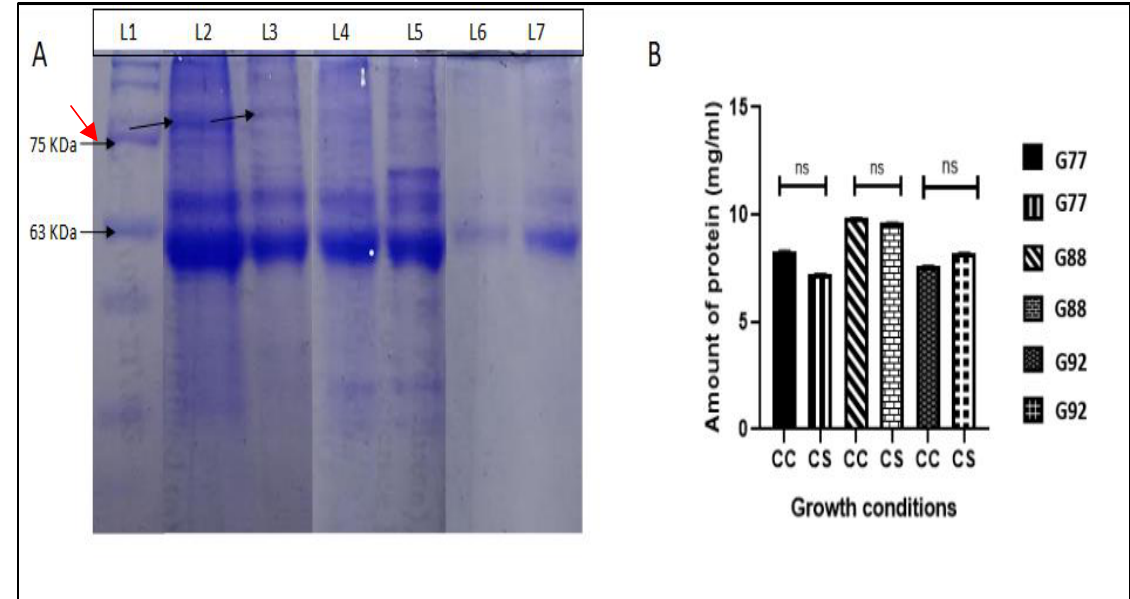
Figure 7. Total protein estimation in the selected genotypes after CS. ( A ) Total protein extracts were separated in a SDS-PAGE. L1-Protein marker L2-G77 at CC, L3-G77 at CS, L4-G88 at CC, L5-G88 at CS, L6-G92 at CC, L7-G92 at CS. Black arrow in L2 and L3 indicate B1 (~75kDa) from G77. Red arrow in L5 indicate B2 (~70 kDa) from G88 ( B ) total protein quantification was carried out using amido black method from 8-day-old seedlings grown at CS. G77, G88 and G92 are the genotypes, PAU911, PUSA1672 and PUSA9531 respectively. Statistical significance using one-way ANOVA indicated as ns: Non-significant.